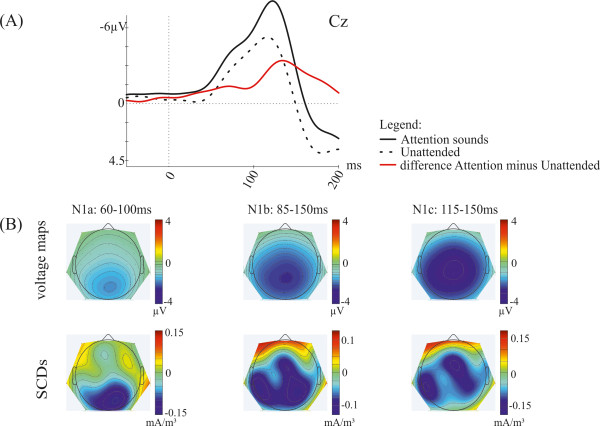
Illustration of the attention sound effect. (A) Grand-average ERPs (mean of self-initiated and externally-initiated sounds) at Cz elicited by attending the sounds (black solid line), not attending the sounds (black dotted line), as well as the difference wave (attended minus unattended, red line). (B) Voltage maps and scalp current densities (SCDs) of the difference wave during the latency ranges of the N1a (60–100 ms), N1b (85–150 ms) and N1c (115–150 ms) time window.